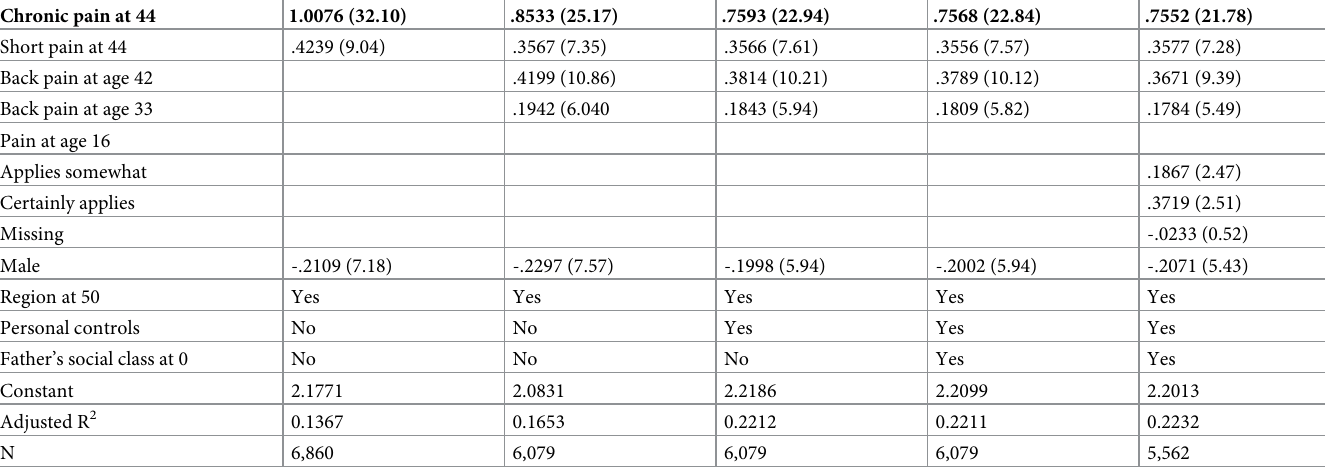
Table 8. Bodily pain in NCDS8 at age 50 (OLS).